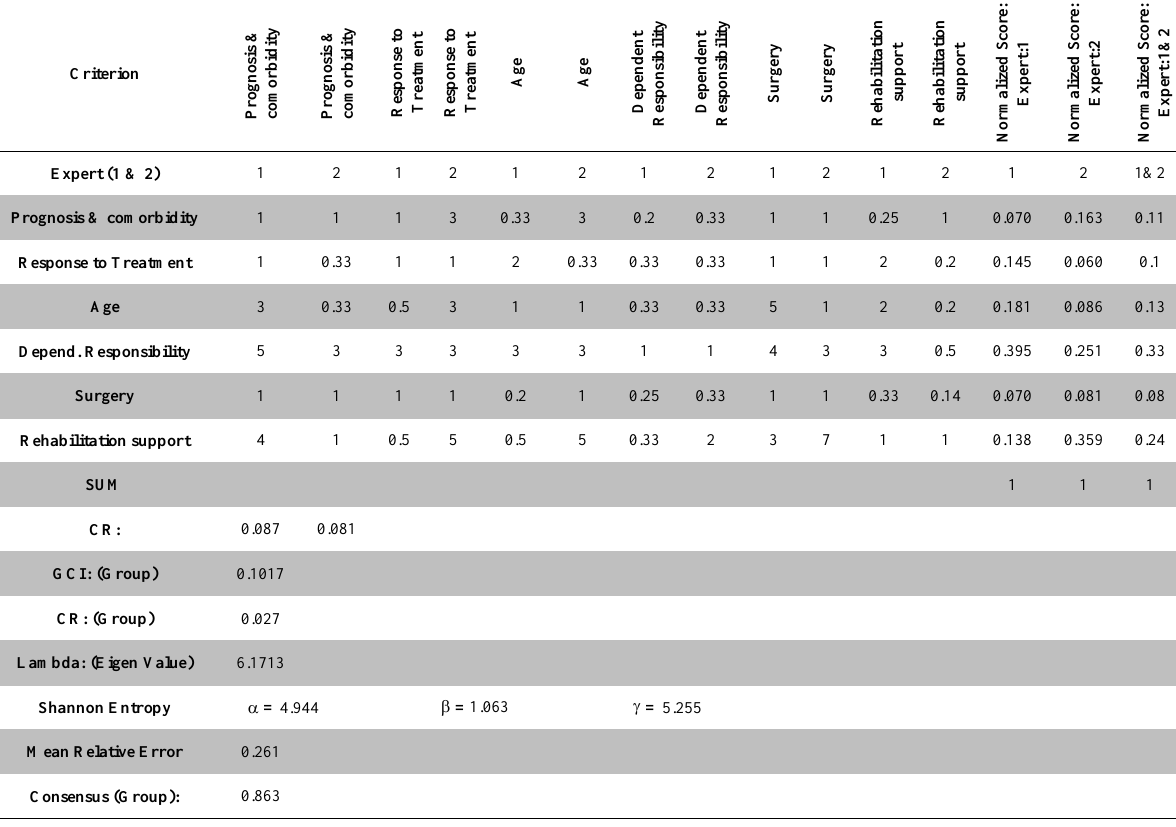
Table 12. Decision Matrix A: About Patient Case 3 (Expert 1 and 2)